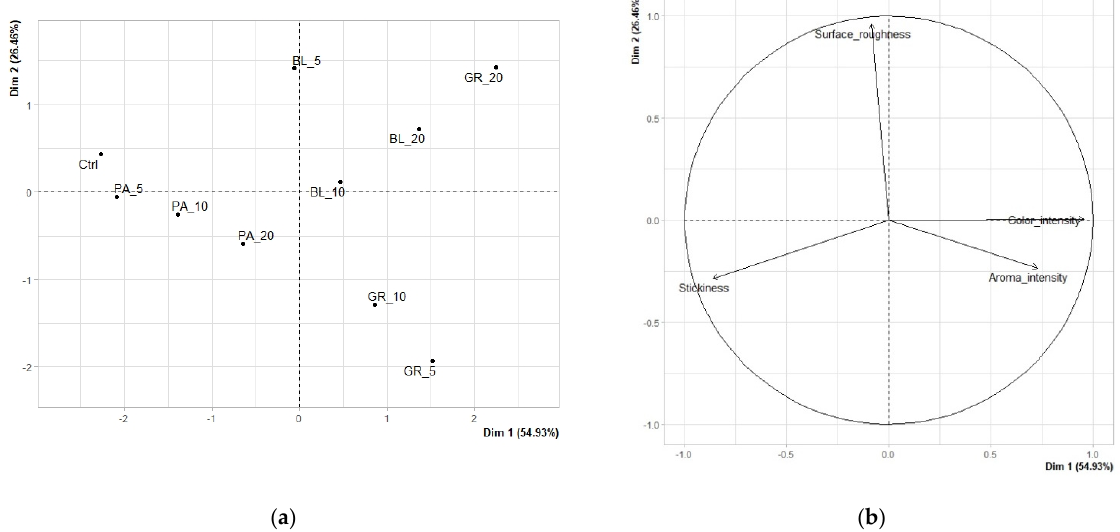
Figure 1. The results of PCA of quantitative descriptive analysis of edible coatings: ( a ) Score plot for the mean points (BL_5, edible coating with 5% of blueberry extract; BL_10, edible coating with 10% of blueberry extract; BL_20, edible coating with 20% of blueberry extract; GR_5, edible coating with 5% of red grape extract; GR_10, edible coating with 10% of red grape extract; GR_20, edible coating with 20% of red grape extract; PA_5, edible coating with 5% of parsley extract; PA_10, edible coating with 10% of parsley extract; PA_20, edible coating with 20% of parsley extract; Ctrl, control = edible coating without added extract). ( b ) Variables factor map.